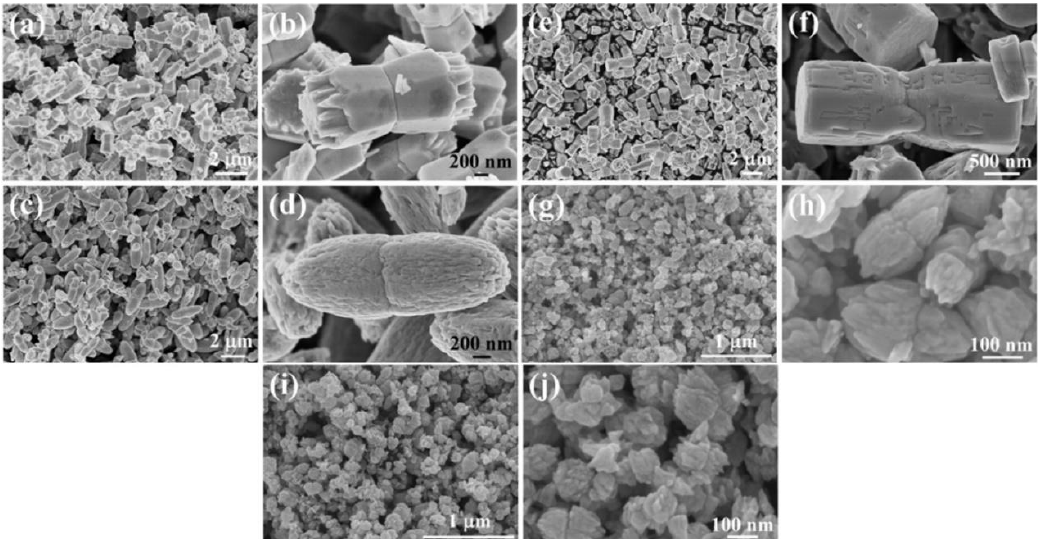
Figure 70. SEM images of ZnO products prepared under different Zn/2-[4-(2-hydroxyethyl)-1- piperazinyl]ethanesulfonic acid molar ratios: 3:8 ( a , b ); 1:4 ( c , d ); 1:8 ( e , f ); 1:20 ( g , h ); 1:40 ( I , j ). Products synthesised the by microwave and ultrasonic wave combined method. Reprinted from [844], Copyright (2013), with permission from Elsevier [OR APPLICABLE SOCIETY COPYRIGHT OWNER]. All rights reserved. In order to re-use permission must be obtained from the rightsholder.